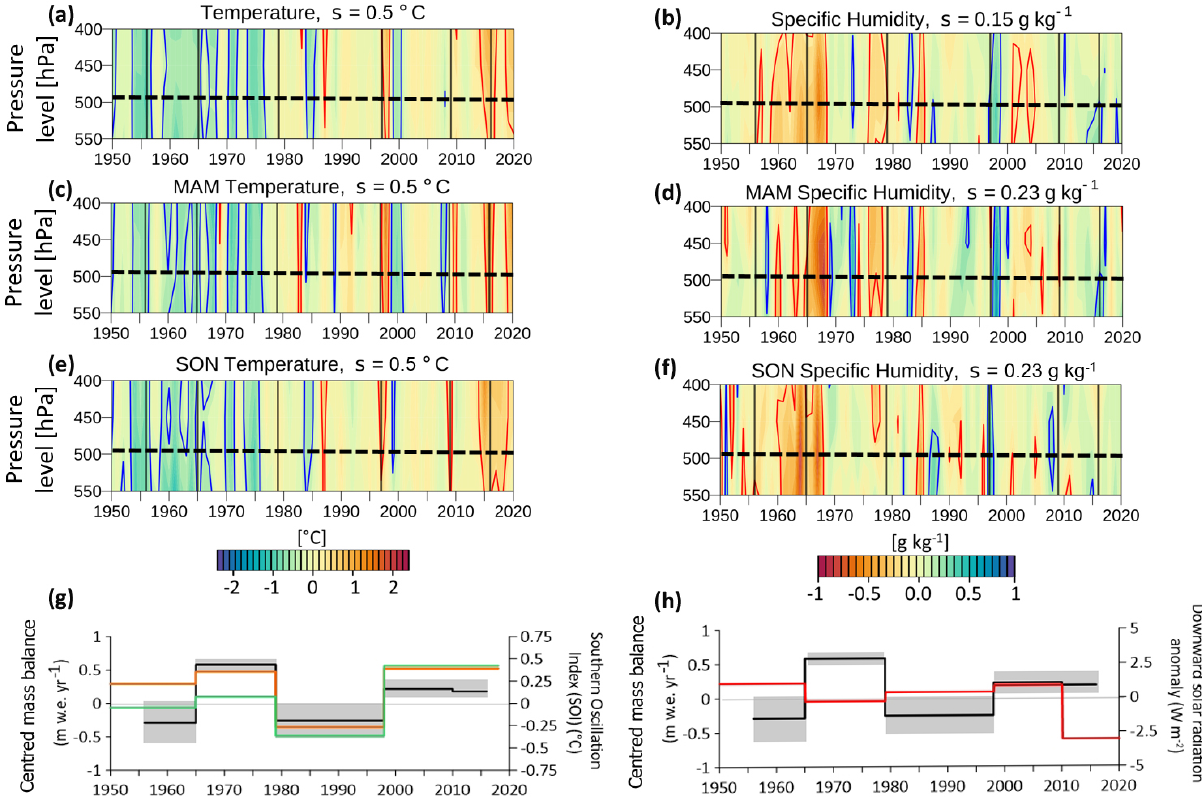
Figure 8. Climate anomalies relative to the current normal climate period 1981–2010 in (a) temperature and (b) specific humidity at pressure levels over the Antisana ice cap. (c, d) The same as in (a) and (b) but for the MAM quarter. (e, f) The same for the SON quarter. Pale to dark red represents warm and dry, whereas pale to dark blue represents cold and humid. The dashed line shows the maximum altitude of the Antisana ice cap. (g) The centred mass balance for the Antisana ice cap (black line) and the (1 σ ) standard deviation (grey-shaded area) for each sub-period; the orange (green) line represents SOI fluctuation averaged over the MAM (SON) quarter. (h) The centred mass balance compared with the 11-month moving average of the downward solar radiation anomaly over the Antisana ice cap (red